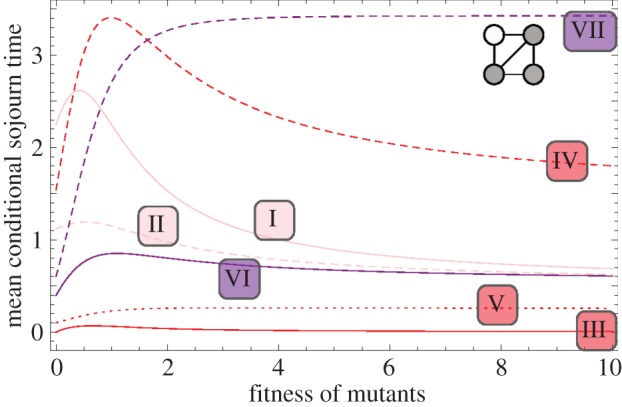
The expected conditional sojourn time in the seven transient states of the diamond. Here, the sojourn time is plotted as a function of the mutant's fitness r > 0. States I and II have one mutant, states III, IV and V correspond to two mutants and states VI and VII have three mutants (see figure 3). (Online version in colour.)